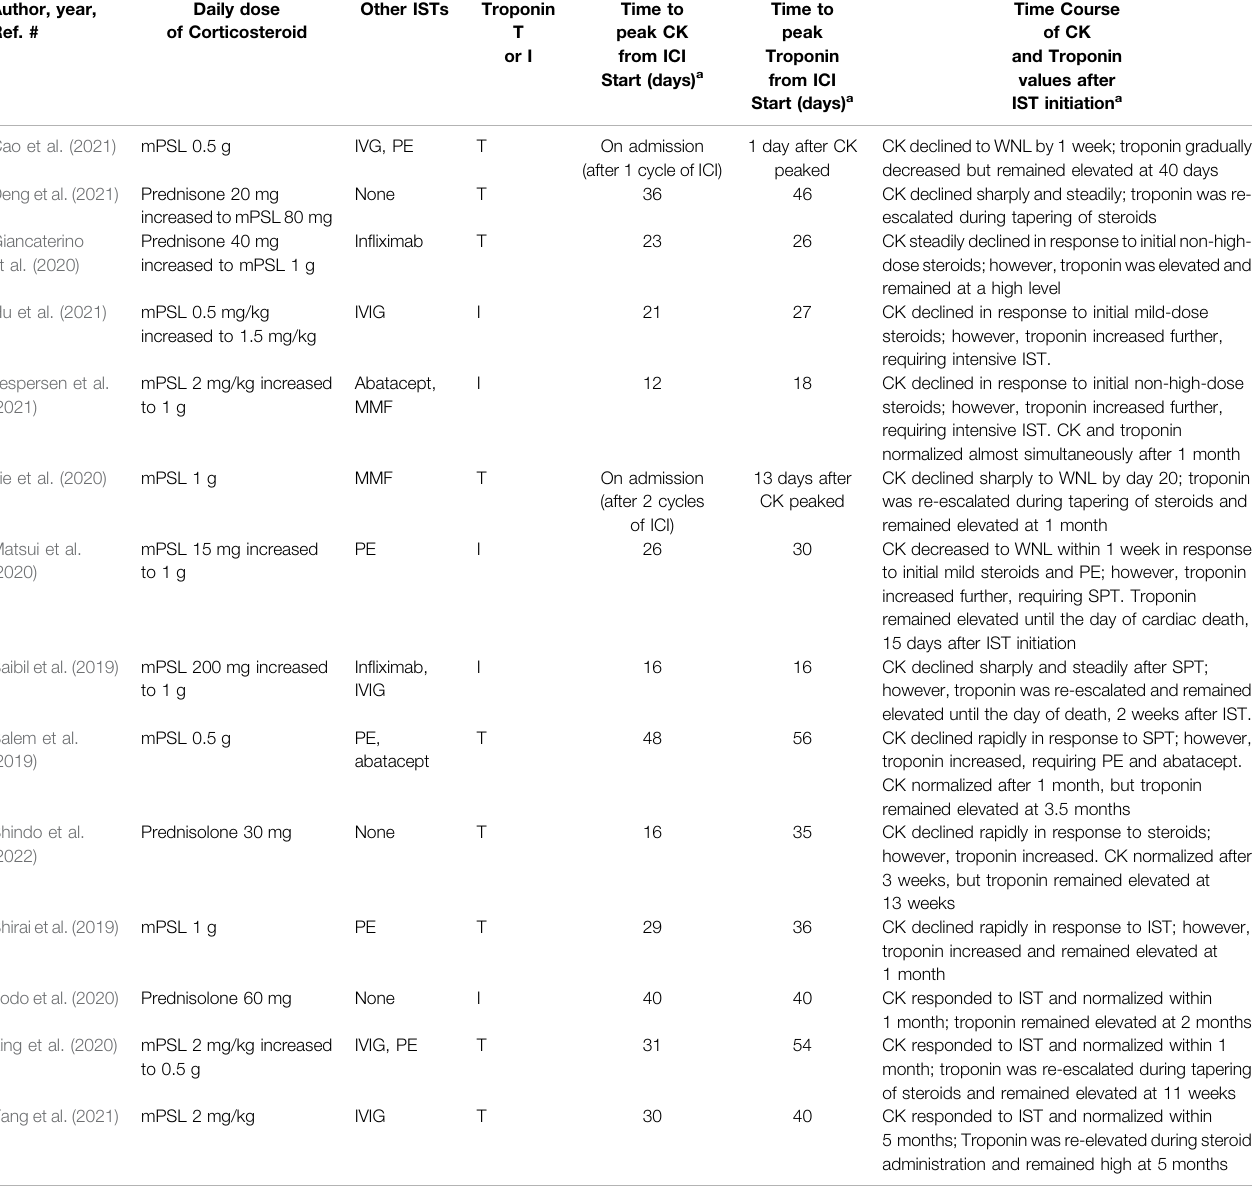
TABLE 4 | Treatment responsiveness of previously reported